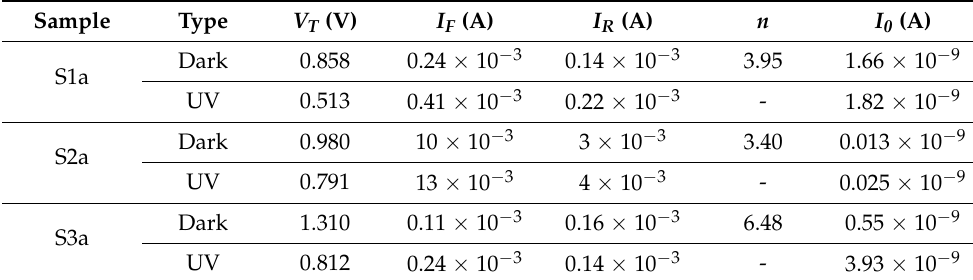
Table 3. Electrical parameters of the n -TiO 2 / p -CuMnO 2